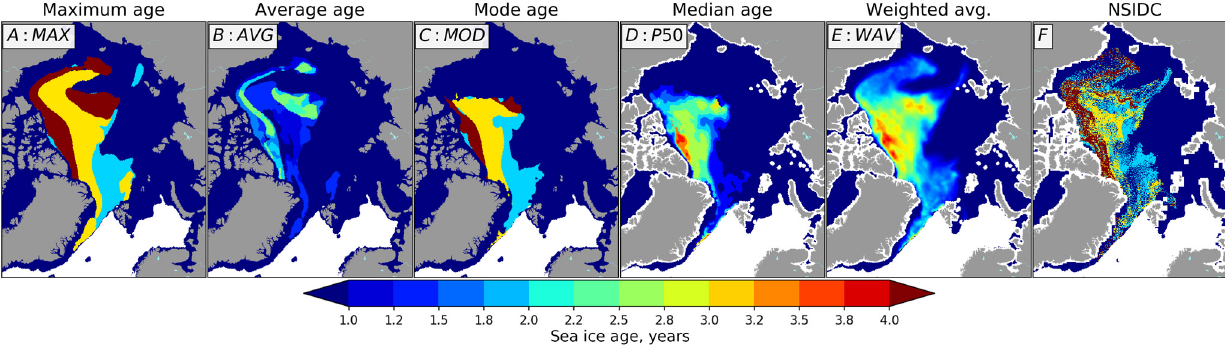
Figure 5. Maps of sea ice age on 1 March 2015 computed with different methods. (a) Maximum ice age; (b) average ice age; (c) modal ice age; (d) weighted average ice age; (e) median (percentile 50) ice age; (f) NSIDC SIA. Color bar represents the sea ice age in